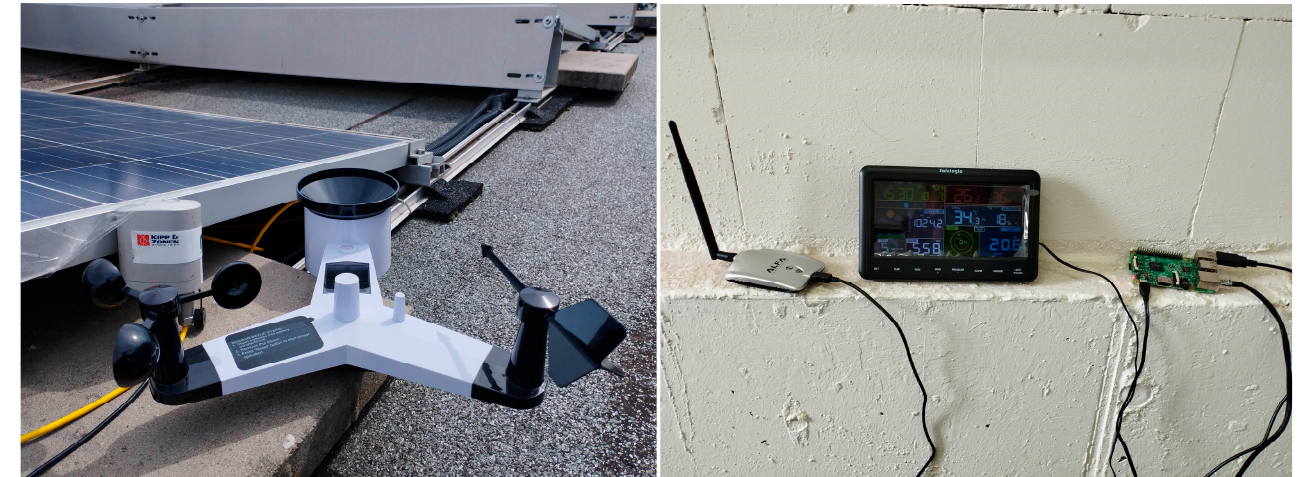
Figure 3. PV irradiance sensor, temperature sensor and weather station.